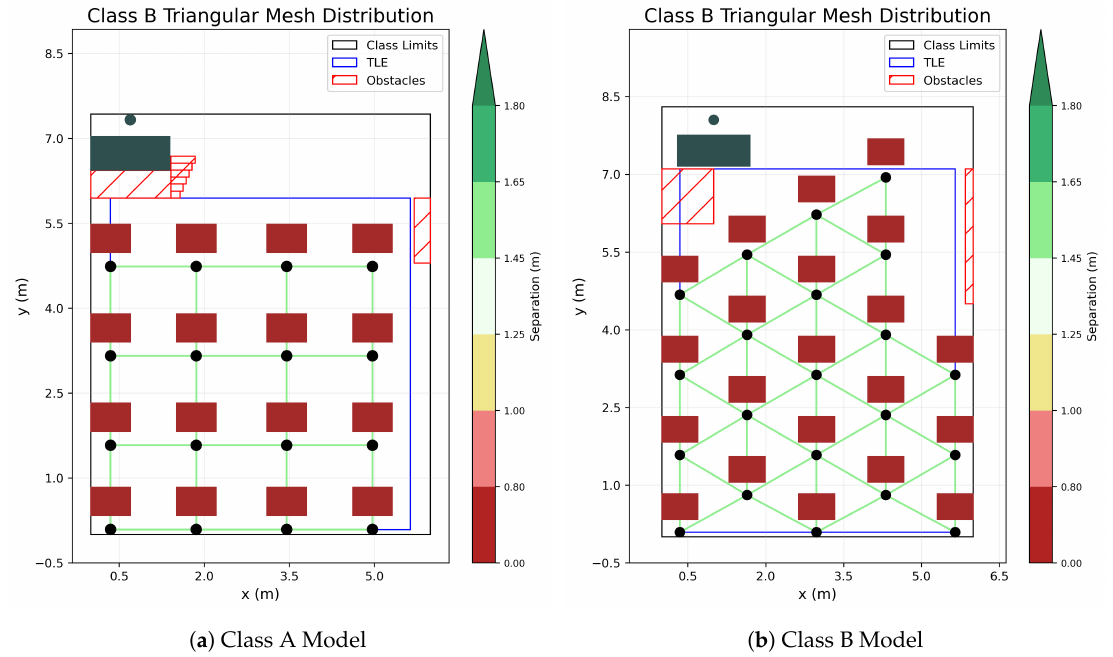
Figure 2. Models for the two classrooms under study, Class A ( a ) deployed an orthogonal mesh distribution while Class B ( b ) displayed a triangular mesh table